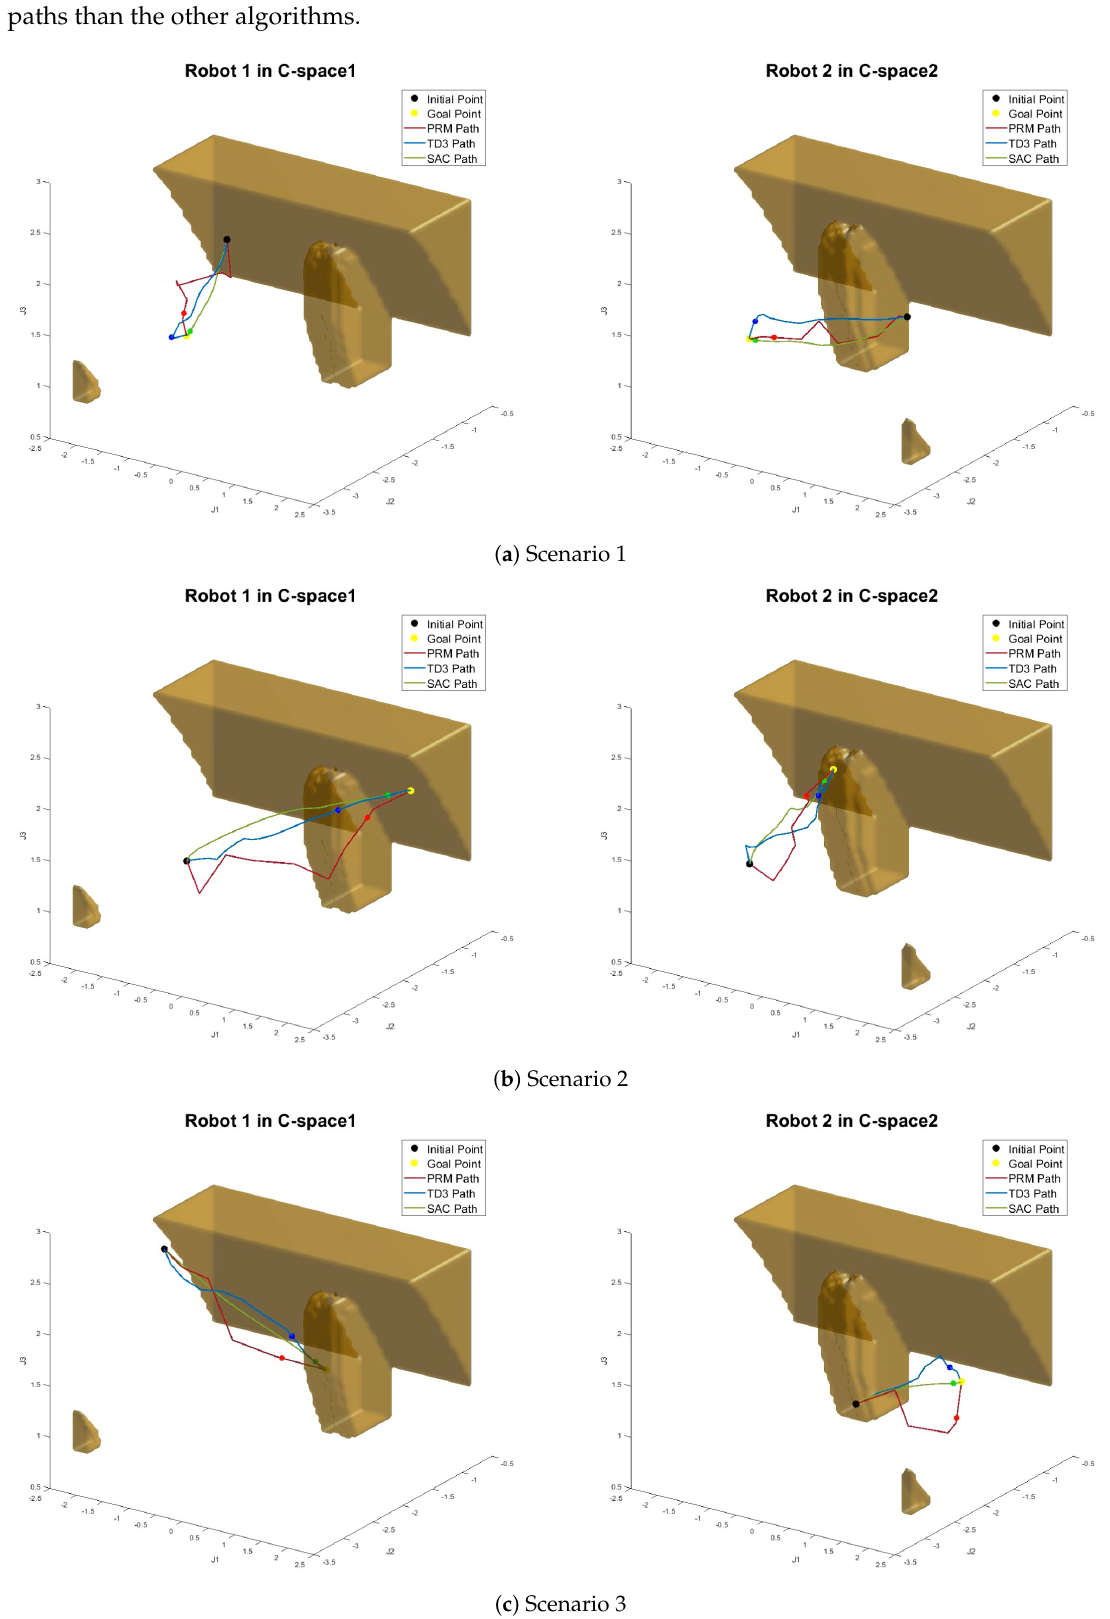
Figure 11. Path generation by SAC with HER for arbitrary initial and goal points in each C-space